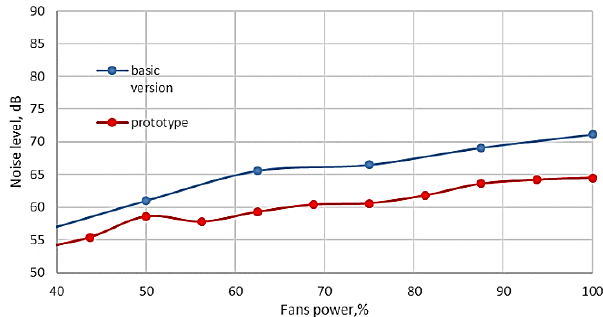
Fig. 15. Results of noise level measurements – comparison of the base and prototype versions (developed on the basis of numerical analysis)